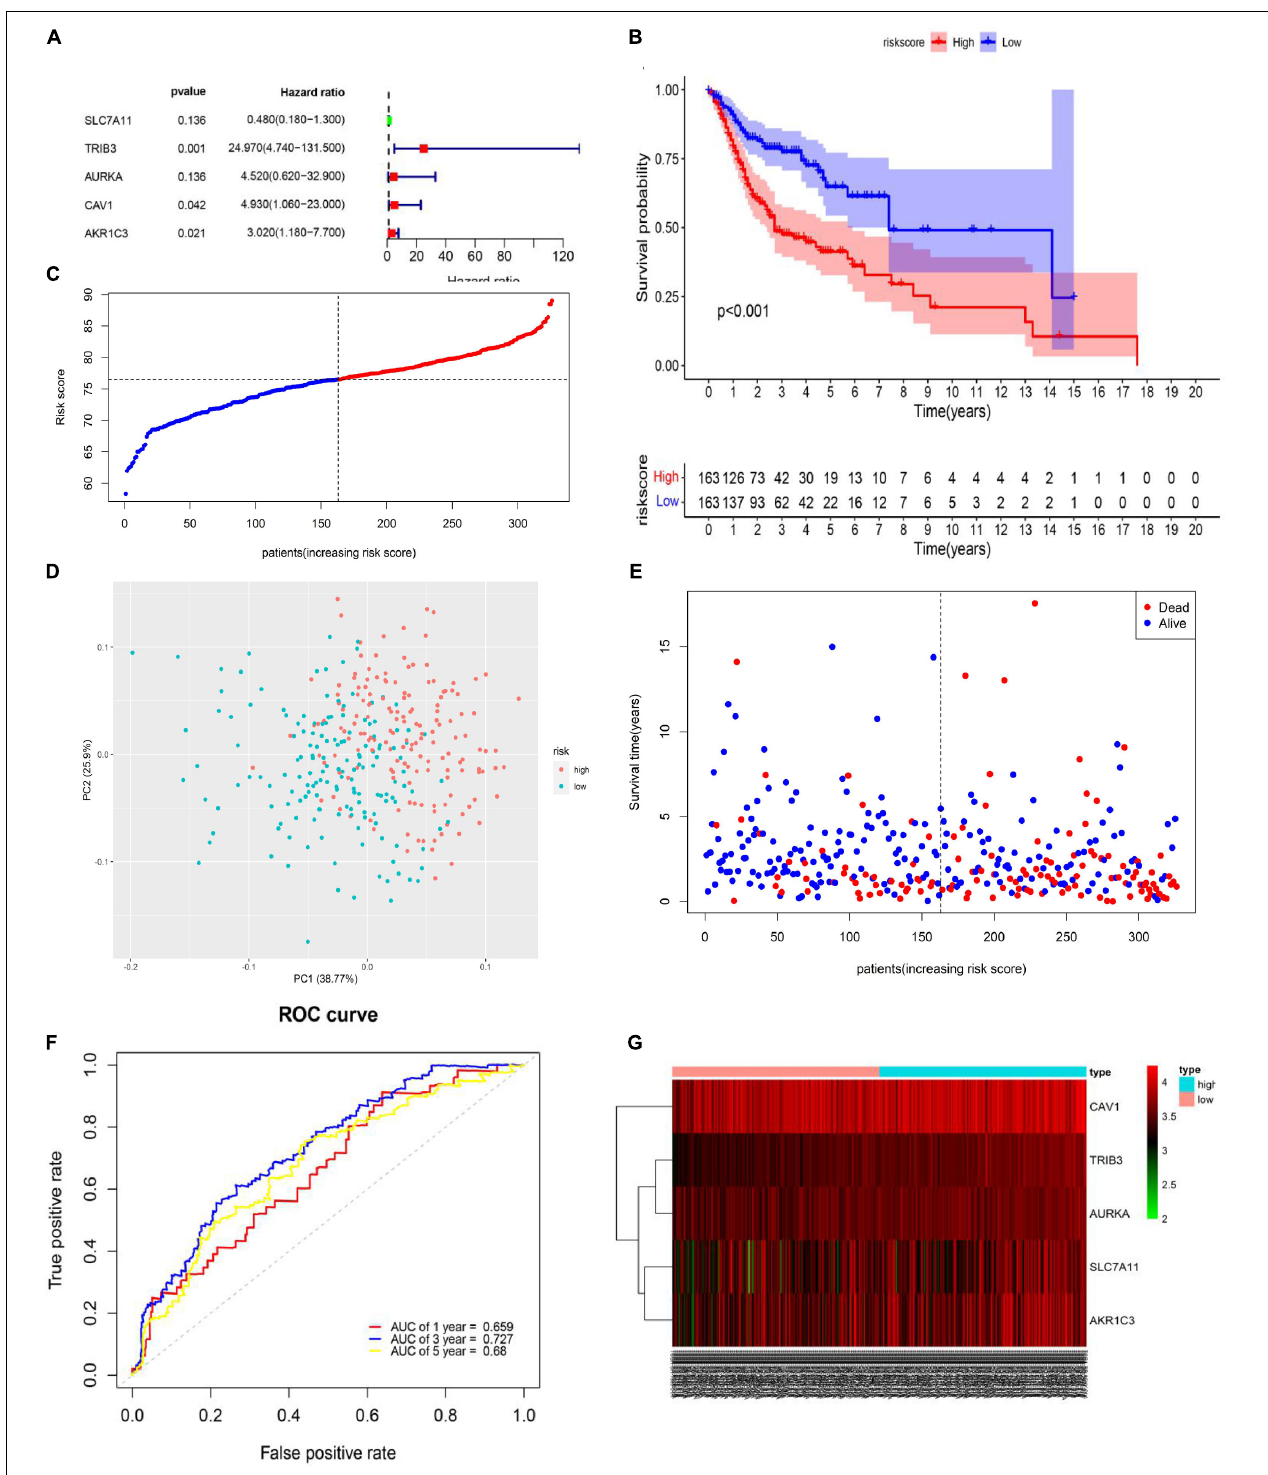
FIGURE 3 | Generation of the prognostic model including ferroptosis-related genes (FRGs) from the cancer genome atlas (TCGA) training set. (A) Multivariate Cox regression analysis results. (B) Kaplan-Meier curves for the different risk groups in the TCGA training set. Log-rank test, P < 0.001. (C) Distribution of different risk groups. (D) Principal component analysis plot of the TCGA training set. (E) Patient survival status and risk score distribution in the TCGA training set. (F) Area under the time-dependent receiver operating characteristic curve in the TCGA training set. (G) Relationships between prognostic FRG expression levels and different risk